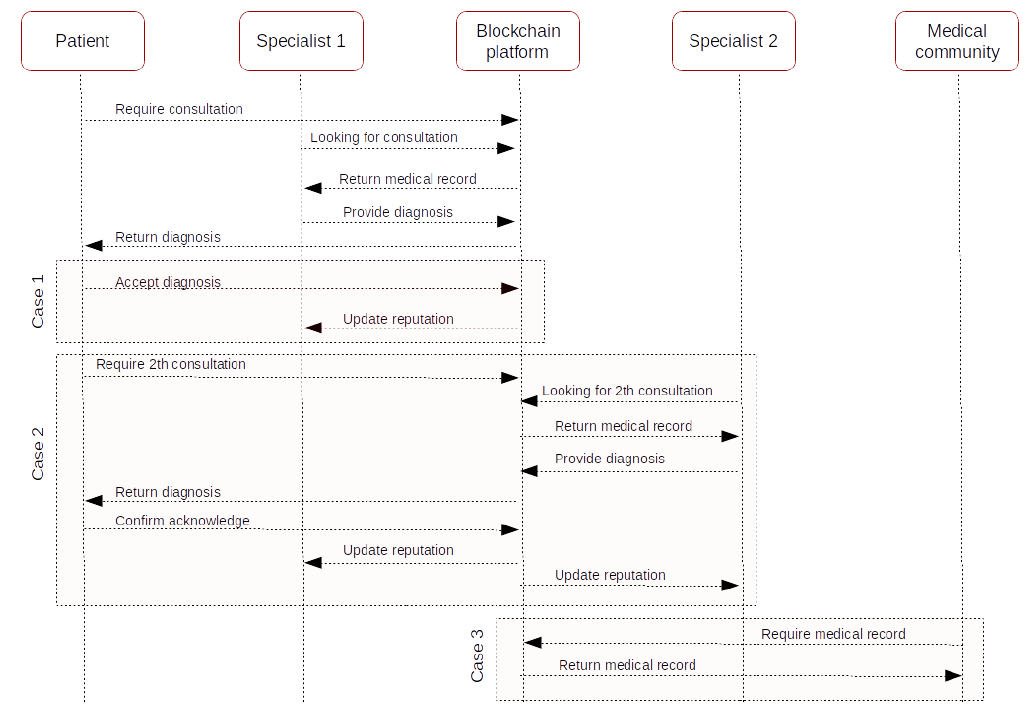
Figure 4. Diagnosis BC procedures: Three use